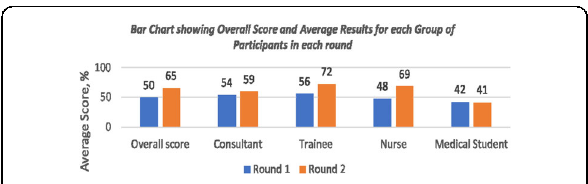
Fig. 1 (abstract 001344). See text for